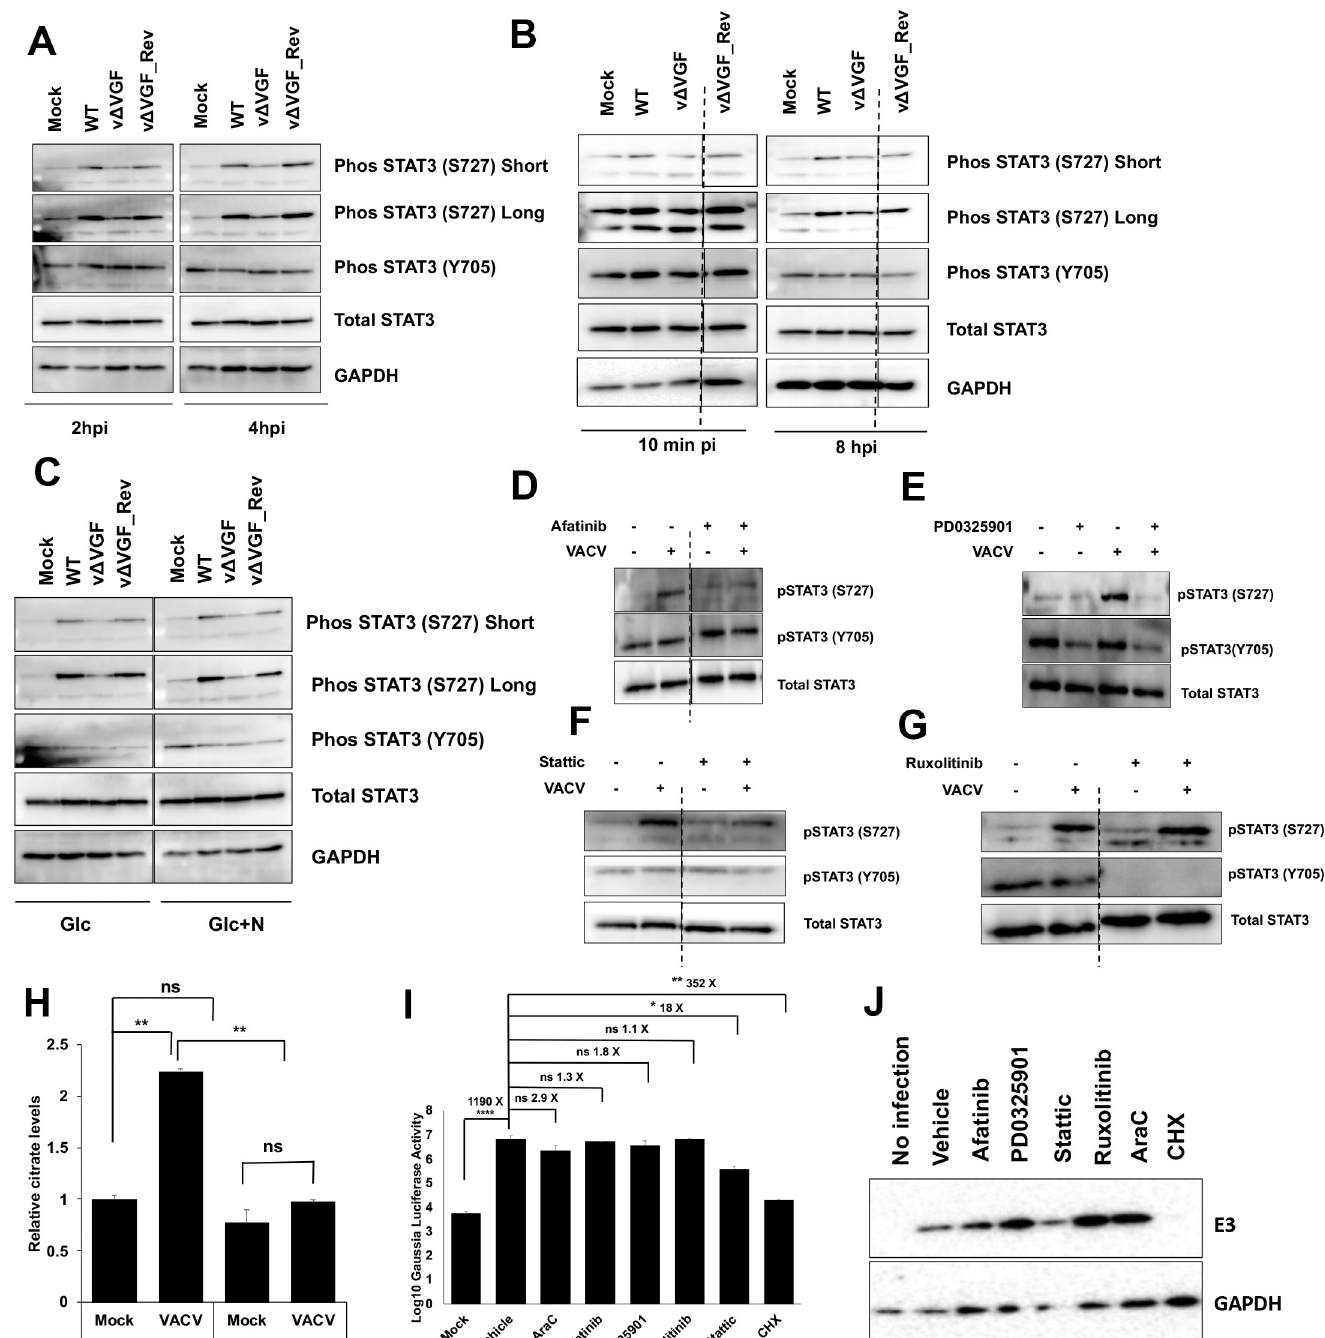
Fig 7. VACV infection induces non-canonical STAT3 phosphorylation at S727 in a VGF-dependent manner. (A) VACV VGF is indispensable to activate STAT3 (S727) phosphorylation. HFFs infected with indicated viruses at an MOI of 5 for the indicated time. Western blotting analysis was performed to measure the levels of various forms of STAT3. ( B) Upregulation of STAT3 S727 phosphorylation starts early during VACV infection. HFFs infected with indicated viruses at an MOI of 5. The samples were collected at 10 min post-infection and 8 hpi, respectively, followed by Western blotting analysis. (C) VACV activates STAT3 (S727) phosphorylation in the absence of glutamine in the medium. HFFs were infected with indicated viruses at an MOI of 5 in medium with glucose only (Glc) or with glucose+asparagine (Glc+N). Protein levels were detected by performing a Western blotting analysis at 4 hpi. (D) Inhibition of the EGFR pathway decreases STAT3 S727 phosphorylation in VACV infected cells. HFFs were infected with MOI of 5 of WT-VACV with or without 3 μ M afatinib treatment. Western blotting analysis was performed at 4 hpi to test the levels of different forms of STAT3 protein. (E) Inhibition of the MAPK pathway decreases both Y705 and S727 phosphorylation. HFFs were infected with MOI of 5 of VACV in medium with or without 20 μ M PD0325901 treatment. Western blotting analysis was performed at 2 hpi to detect the